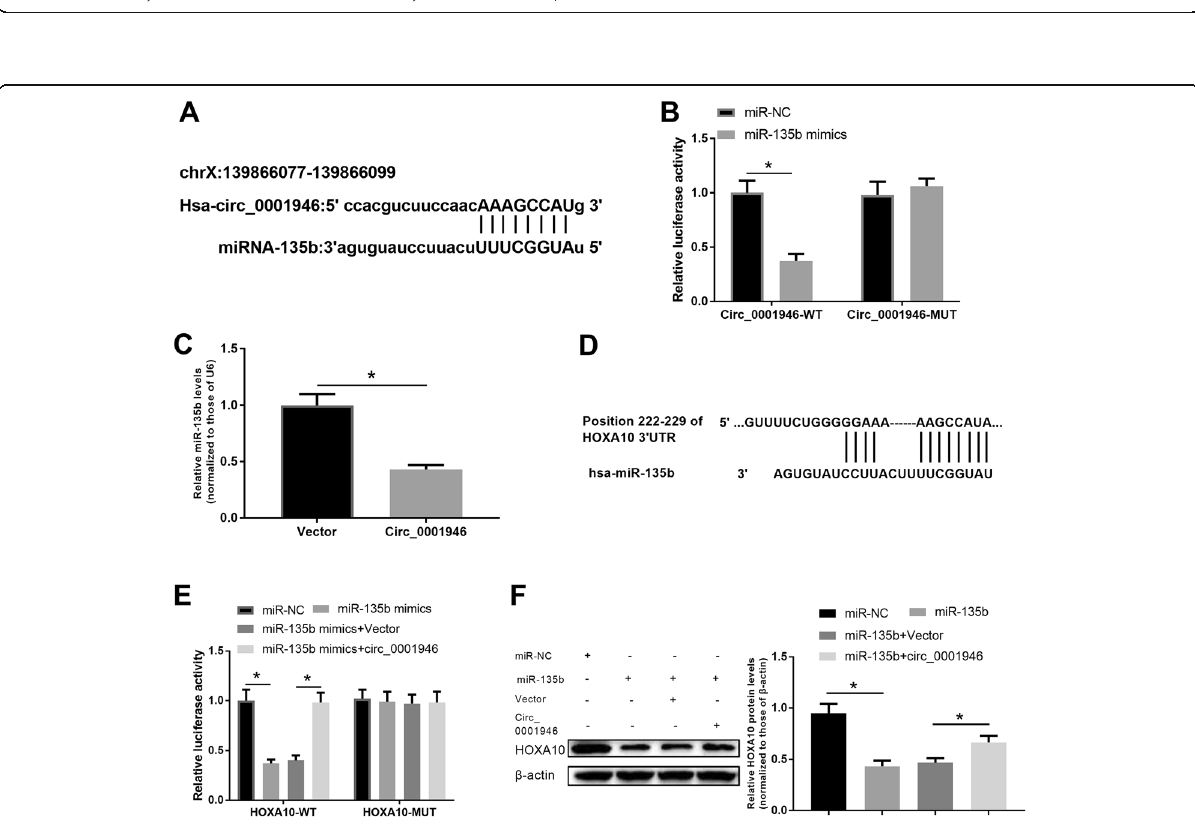
Fig. 2 Hsa_circ_001946 functions as a sponge of miR-135b and HOXA10 is a target gene of miR-135b in T-HESCs. a. Predicted binding sites for miR-135b on hsa_circ_001946 by circinteractome. b. Dual luciferase reporter assays for interaction between hsa_circ_001946 and miR-135b. c . Quantitative RT-PCR analyses for expression of miR-135b in T-HESCs transfected with hsa_circ-001946. d. Predicted binding sites for miR-135b on the 3 ’ UTR of HOXA10 by TargetScan. e . Dual luciferase reporter assays for interaction among miR-135b, HOXA10 and hsa_circ-001946. f . Western blot analyses for the expression of HOXA10 in T-HESCs transfected with hsa_circ_001946 and/or miR-135b. * P <